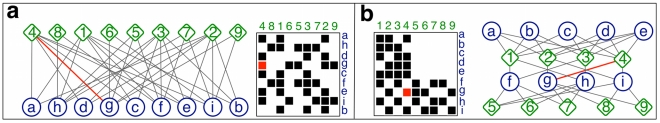
An actor-event network and its adjacency matrix.
a, In the network, actors are represented as circles, events as diamonds. Links indicate the participation of an actor in an event. In the adjacency matrix, actors are represented by rows and events by columns. A non-zero (non-white) entry in row , column  indicates participation of actor  in event . As an example, the edge between event  and actor  is highlighted in all network representations. Without the knowledge of latent classes for either actors or events, both representations appear unstructured. b, The same network as in a, but rows and columns of the adjacency matrix have been reordered, such that blocks in the adjacency matrix become apparent indicating the presence of latent classes of actors and events. We address the challenge of inferring such latent classes through statistical modeling, which leads to assertions of node properties or can generate improved network layouts.